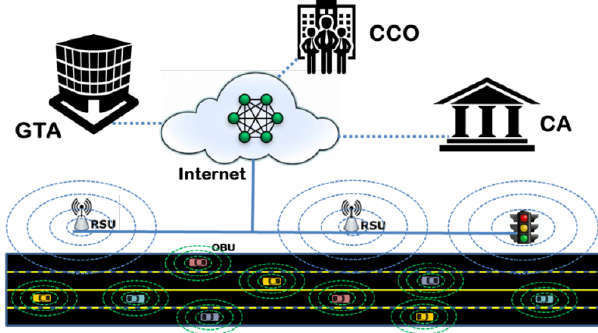
Figure 1. Typical architecture of a vehicular ad hoc network (VANET).